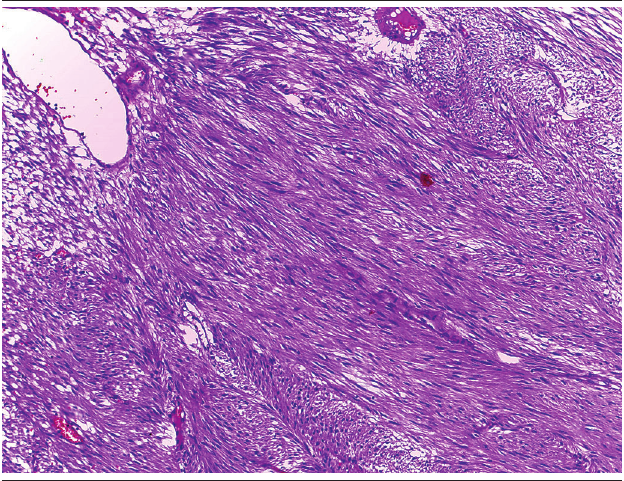
Figura 2 − Microscopia, 400×, HE: células fusiformes, com núcleos alongados e citoplasma abundante HE: hematoxilina e eosina.